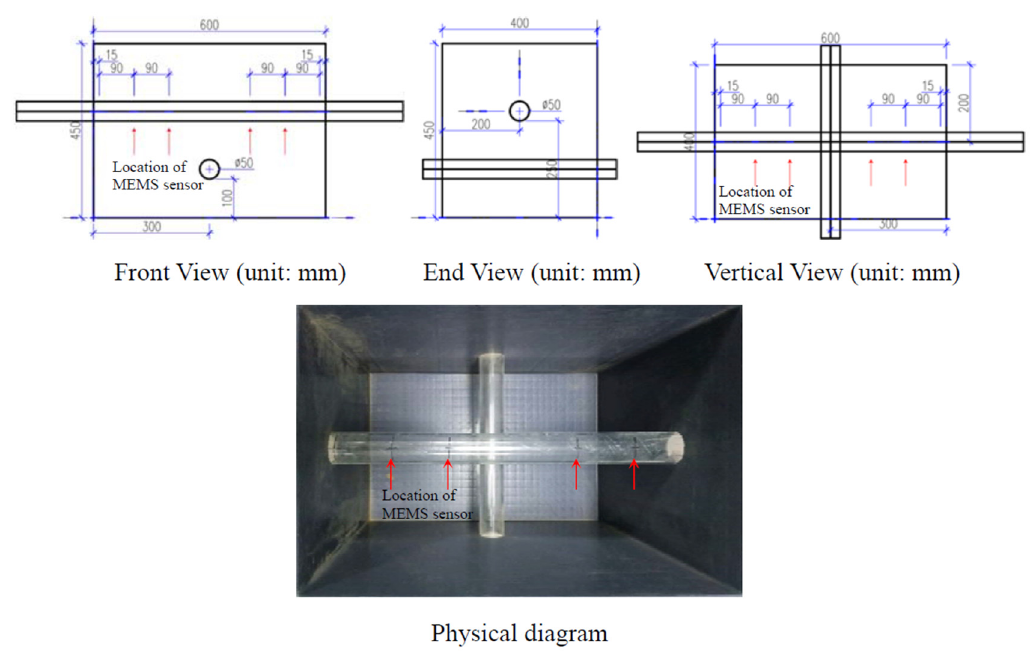
Figure 4. Orthogonal tunnels layout scheme.